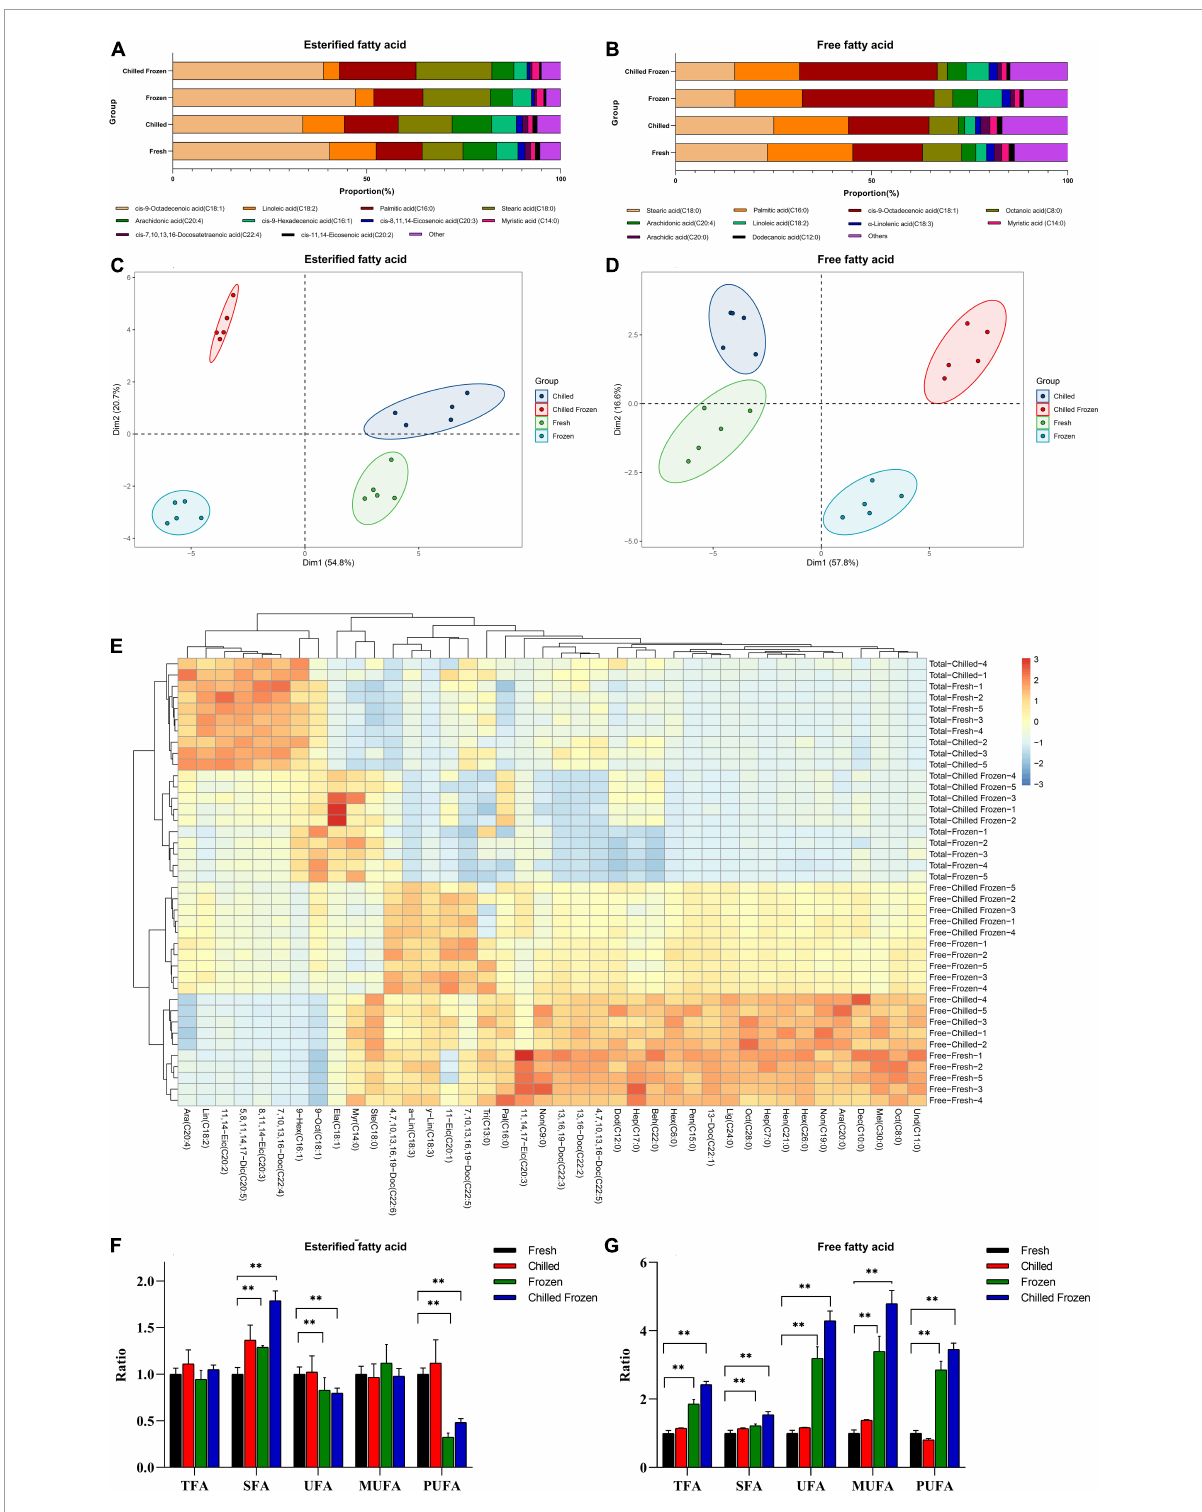
FIGURE7 The ratio of (A) esterified FAs and (B) free FAs from meat under different postharvest processes; PCA-Biplot analysis of (C) free FAs and (D) esterified FA under various harvest processes; (E) the Heatmap of forty FAs from meat under various postharvest. The ratios of TFA, SFA, UFA, MUFA and PUFA in esterified FAs (F) and free FAs (G) from meat under different postharvest processes. Data were represented as the mean ± standard deviation ( n = 5). ** p < 0.01 was considered as significantly